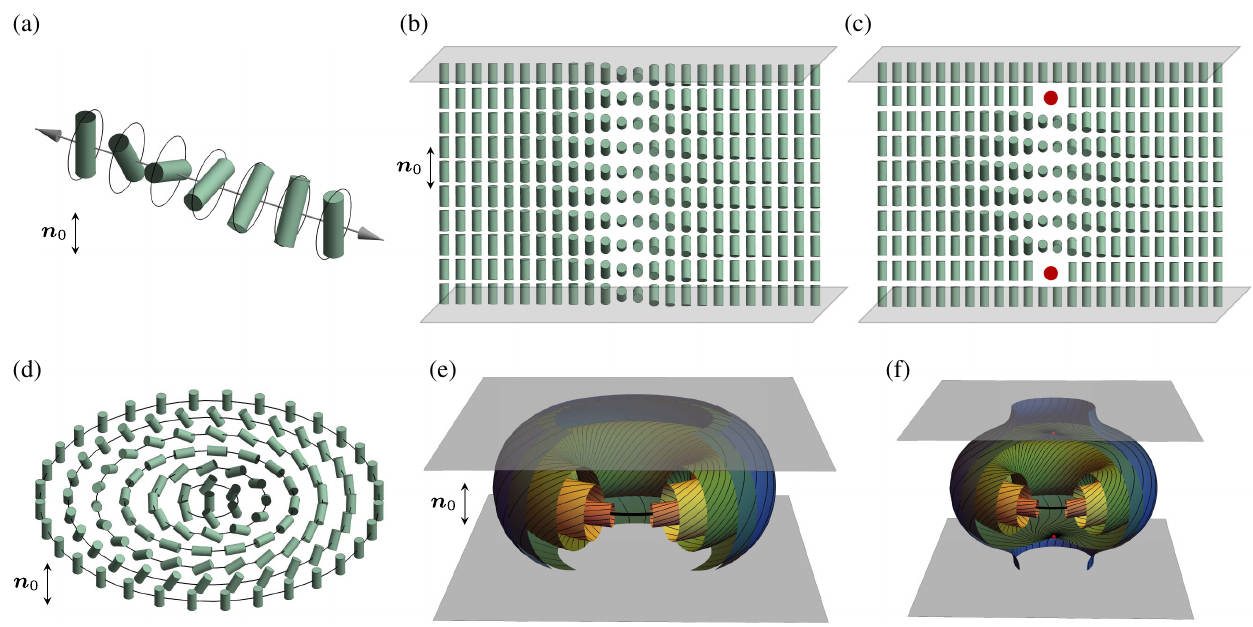
FIG. 1. (a) Schematic representation of a 1D soliton with a π twist in a nonpolar LC. The orientation of the LC director is represented by cylinders, and the far field is denoted by n 0 . (b) 3D embedding of the wall shown in (a) between plates (in gray) with moderate homeotropic anchoring. (c) Same as (b) with strong homeotropic anchoring. Two defect lines (in red) are necessary to accommodate the boundary conditions. (d) Schematic representation of a 2D soliton dubbed elementary skyrmion with a vortex of π twist from its center in all radial directions. (e) 3D embedding of the elementary skyrmion shown in (d) between two plates (in gray) with moderate homeotropic anchoring; no singular defects are present in this LC bulk. The director field lines resting on nested toroidal surfaces are represented in black. (f) Same as (e) with strong homeotropic anchoring; similar to (c), two defects (in red) are present due to the strong anchoring. The colors of the surfaces in (e),(f) are only there for visual enhancement and do not have special